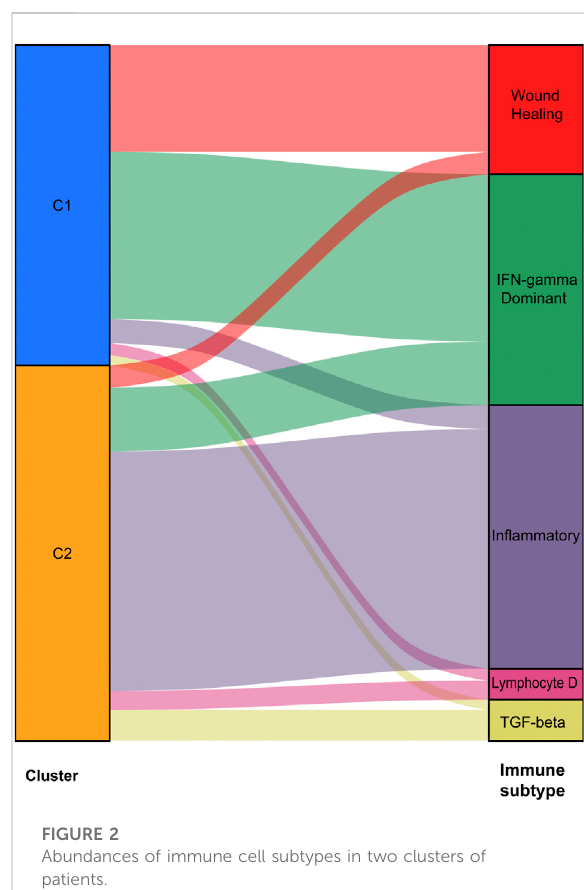
FIGURE 2 Abundances of immune cell subtypes in two clusters of